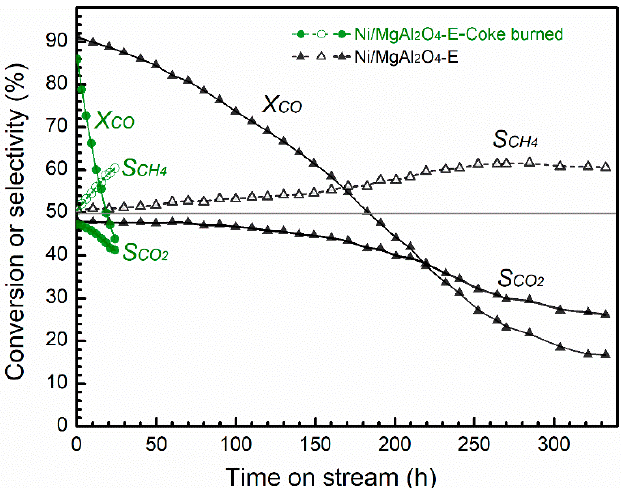
Figure 6. Long-term stability result of the Ni/MgAl 2 O 4 -E catalyst in dry methanation reaction at 450 °C and GHSV of 10,000 mL h − 1 g cat. − 1 .